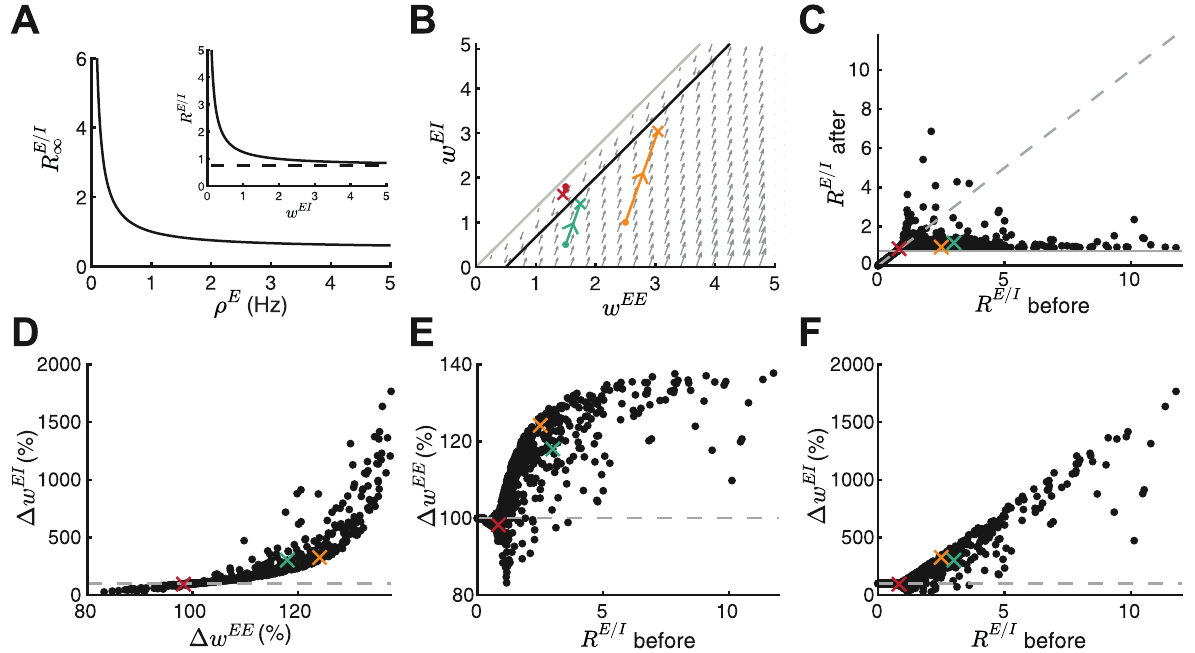
Fig 5. The nonlinear inhibitory plasticity rule maintains an excitatory-to-inhibitory weight ratio. A . The steady state E/I weight ratio R EI as a 1 function of the presynaptic excitatory rate ρ E . Inset: R E / I approaches the steady state N I ν I /( N E ρ E ) (dashed line) for large I-to-E weights. B-F Based on a random initial weight configuration drawn from a uniform distribution in the range of [0, 3], excitatory and inhibitory plasticity was induced for 100 ms. Extreme initial E/I ratios ( R E = I before > 12 ) were excluded from the analysis. B . Phase portrait of the dynamics of E-to-E ( w EE ) and I-to-E ( w EI ) weights. Gray arrows indicate the direction of weight evolution over time, colored points represent three different weight initialization, ½ w EE ; w EI � ¼ f½ 1 : 5 ; 1 : 8 � ; ½ 1 : 5 ; 0 : 5 � ; ½ 2 : 5 ; 1 �g , colored lines represents the weight evolution for each case and the cross marks the weights after plasticity 0 0 induction. The firing rates dynamics are similar as in Fig 2. C . E/I ratio before and after plasticity induction. Crosses indicate examples in B. Gray dashed line indicates the identity line and gray line indicates R E = I . D . E-to-E weight change Δ w EE versus I-to-E weight change Δ w EI after plasticity 1 induction in percent of initial synaptic weights. Dashed gray line indicates initial I-to-E weight strength and crosses indicate examples in B. E . E-to- E weight change Δ w EE as a function of E/I ratio R E / I before plasticity in percent of initial weights. Dashed gray line indicates initial E-to-E weight strength and crosses indicate examples in B. F . Same as E but for I-to-E weight change Δ w EI .